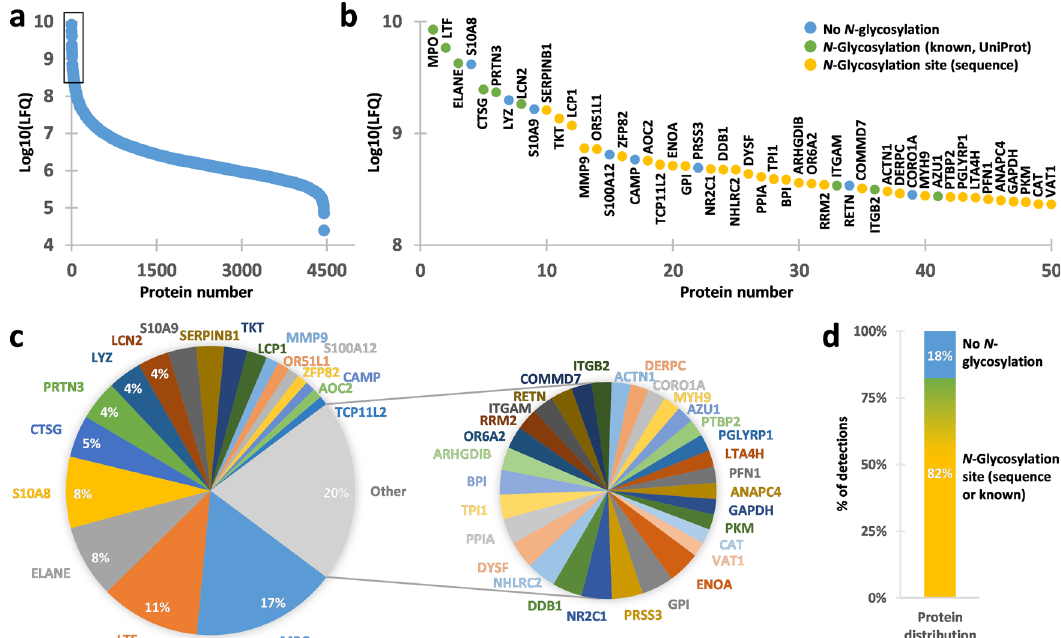
Fig. 2 Quantitative human neutrophil proteome. a Quanti fi cation of 4453 neutrophil proteins detected by LC-MS/MS after lysis of whole neutrophils and subsequent digestion by trypsin and GluC. Proteins were only included into this quanti fi cation when detected in at least two out of three replicates with a minimum of three unique peptides. b Close-up of the top 50 most abundant proteins (encapsulating approximately 65% of the total proteome intensity). The colours indicate whether the known protein sequence contained either no N -glycosylation site (blue; sites being de fi ned as Asn-Xxx-Ser/Thr where Xxx ≠ Pro), at least one site with evidence for N -glycosylation as annotated in UniProt (green), or at least one site predicted by sequence analysis (yellow). c Relative abundance of the top 50 most abundant proteins. d N -Glycosylation site distribution across all detected proteins (nonspeci fi